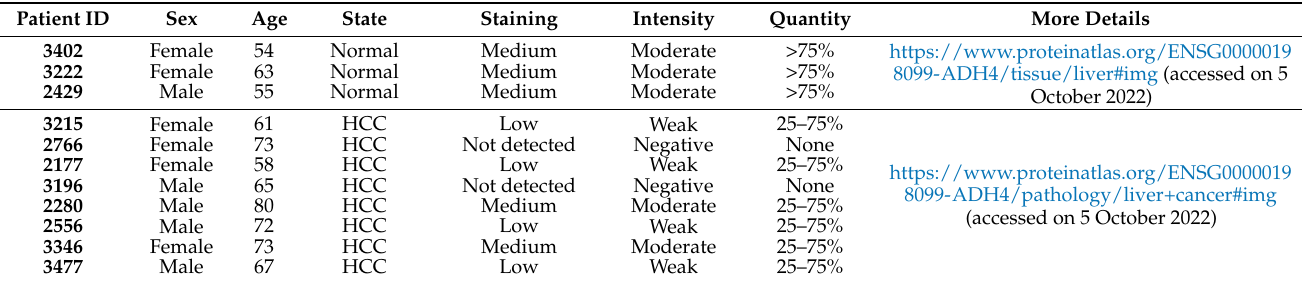
Figure 1. ADH4 is downregulated in hepatocellular carcinoma. ADH4 expression profiles ( A ). ADH4 mRNA expression box plot (statistical parameters included) ( B ). Overall survival of ADH4 in TCGA-LIHC datasets ( C ). Disease-free survival of ADH4 in TCGA-LIHC datasets. Table 1. Patient characteristics for HPA ADH4 expression in HCC and normal liver tissues.